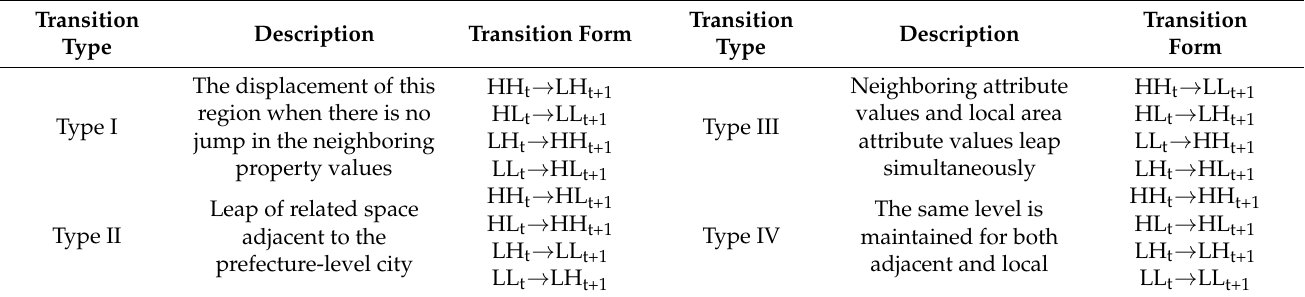
Table 1. Types and descriptions of spatiotemporal